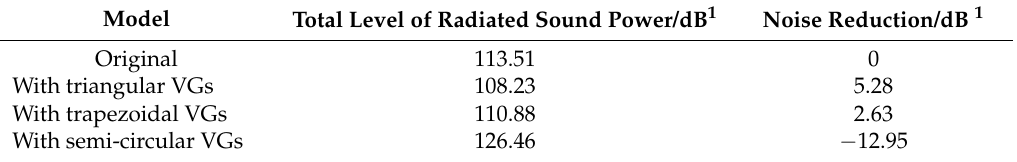
Table 1. The level of radiated sound power from the original model and the models with triangular VGs (vortex generators), trapezoidal VGs, and semi-circular